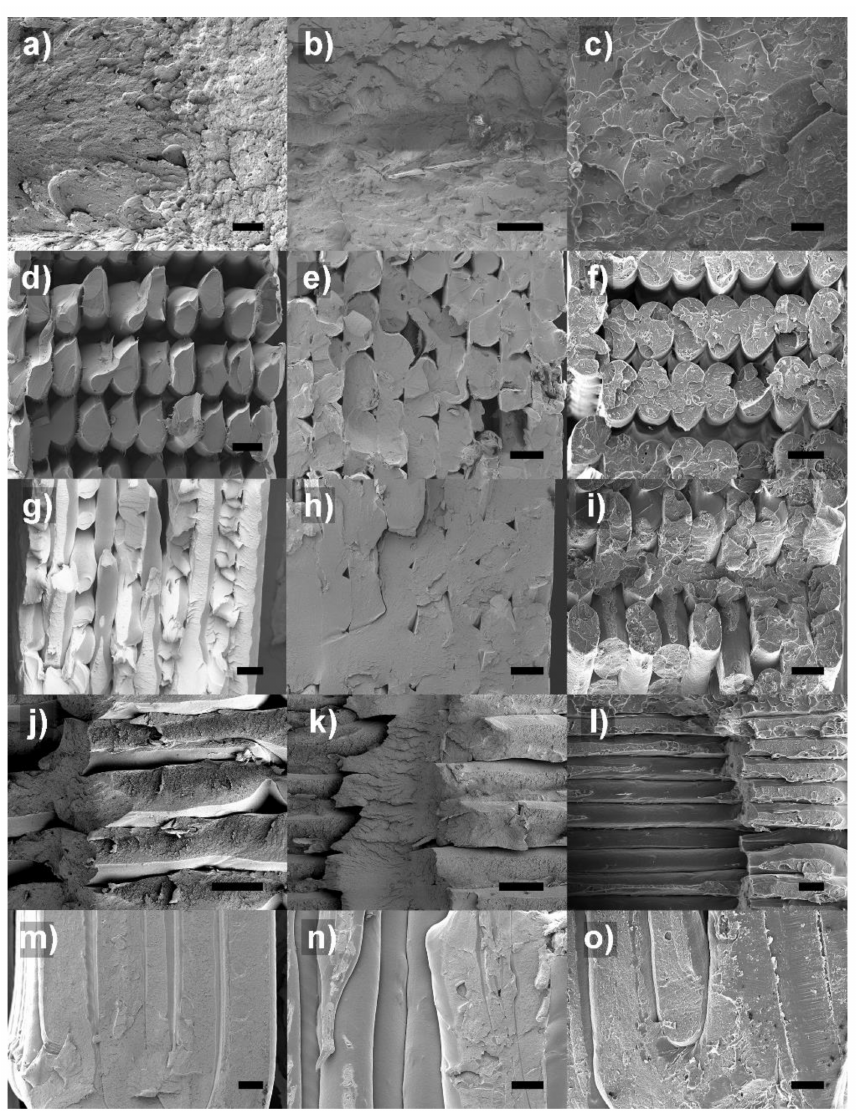
Figure 4. SEM images of the fracture surface of composites manufactured by ( a – c ) IM; ( d – f ) FFF-H0; ( g – i ) FFF, H45; ( j – l ) FFF, H-90, and ( m – o ) FFF, V-90. ASA ASA-3CP, and ASA-3P are presented in the left, middle, and right column, respectively. The scales bar stands for 200 µ m in all